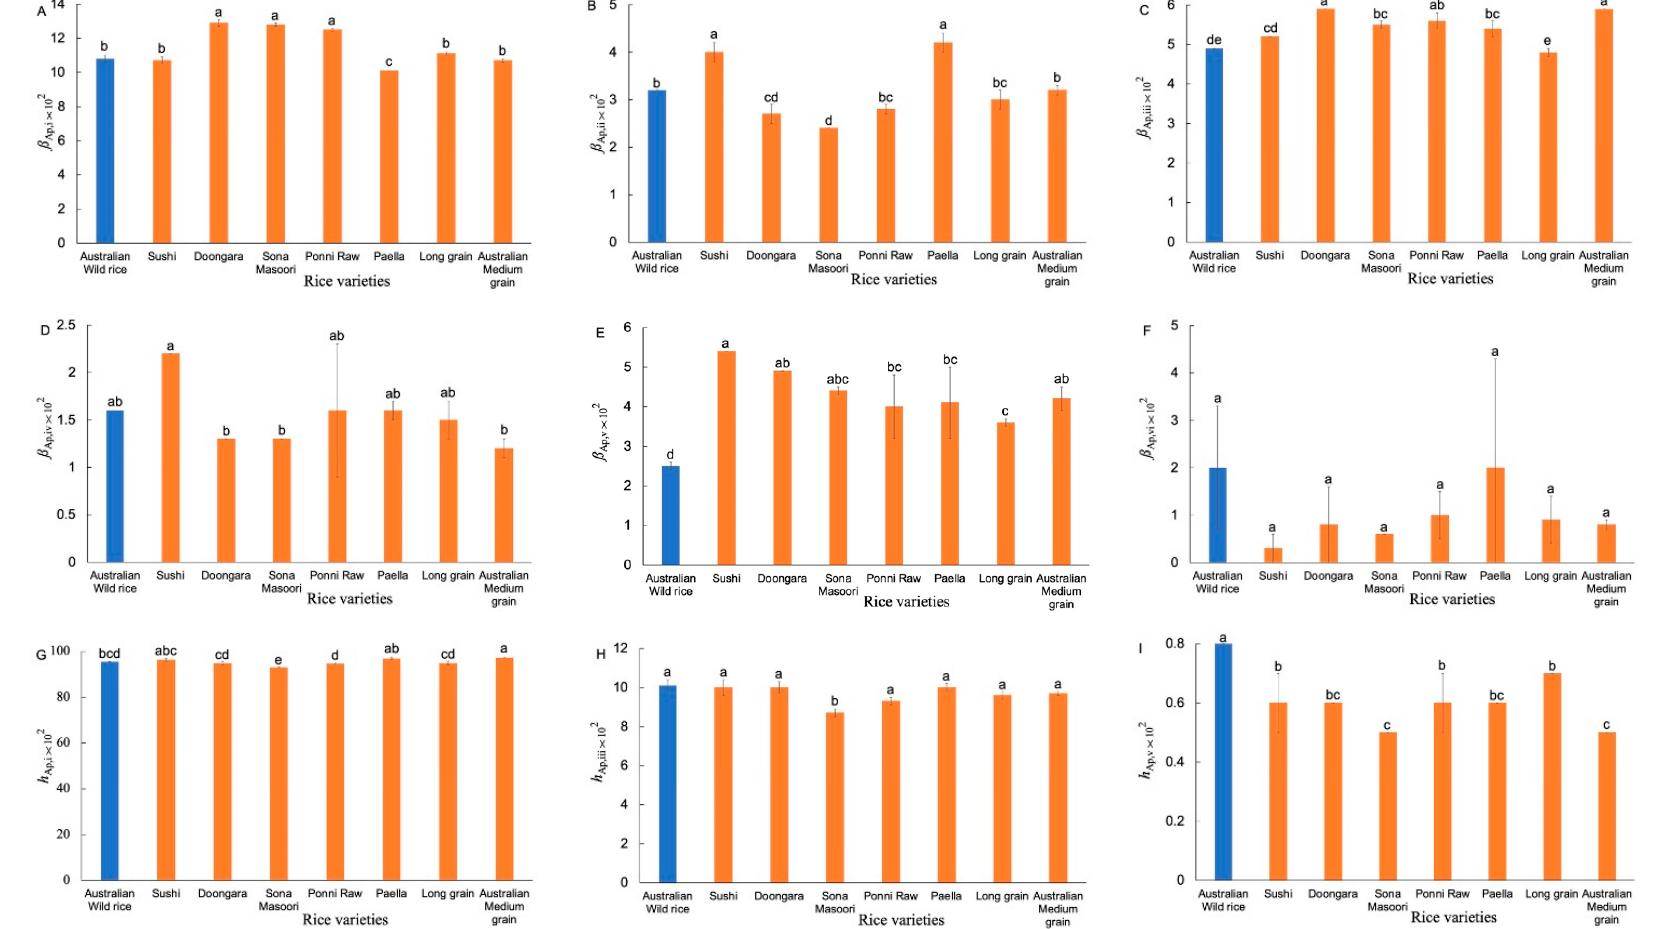
Figure 3. Comparison of Ap structural parameters of AWR starch and CR starches ( A – I ). Blue and red: Australian wild and commercial rices, respectively. All data were from duplicate measurements. The same letters mean no significant difference ( p < 0.05).